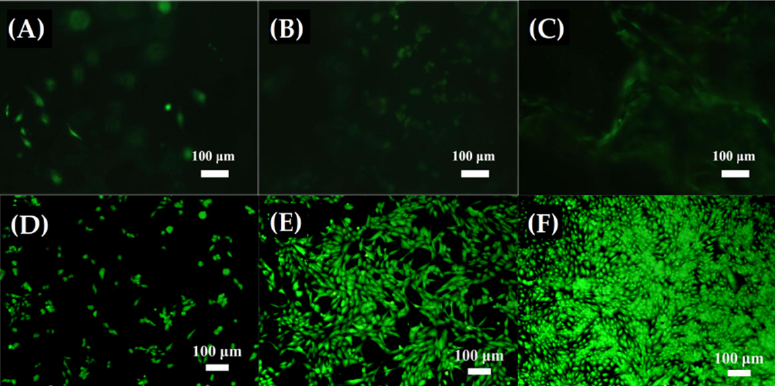
Figure 7. Live/dead immunofluorescence staining results of osteoblast cells cultured for one ( A , D ), three ( B , E ), and five ( C , F ) days on binary glass nanofibrous scaffold ( A – C ), as well as a blank control ( D – F ). Reprinted from Luo et al. [55], copyright (2017), with permission from Materials Science and Engineering: C.